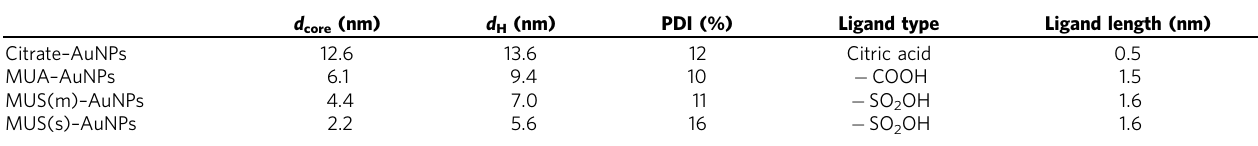
Table 1 | Summary of NP